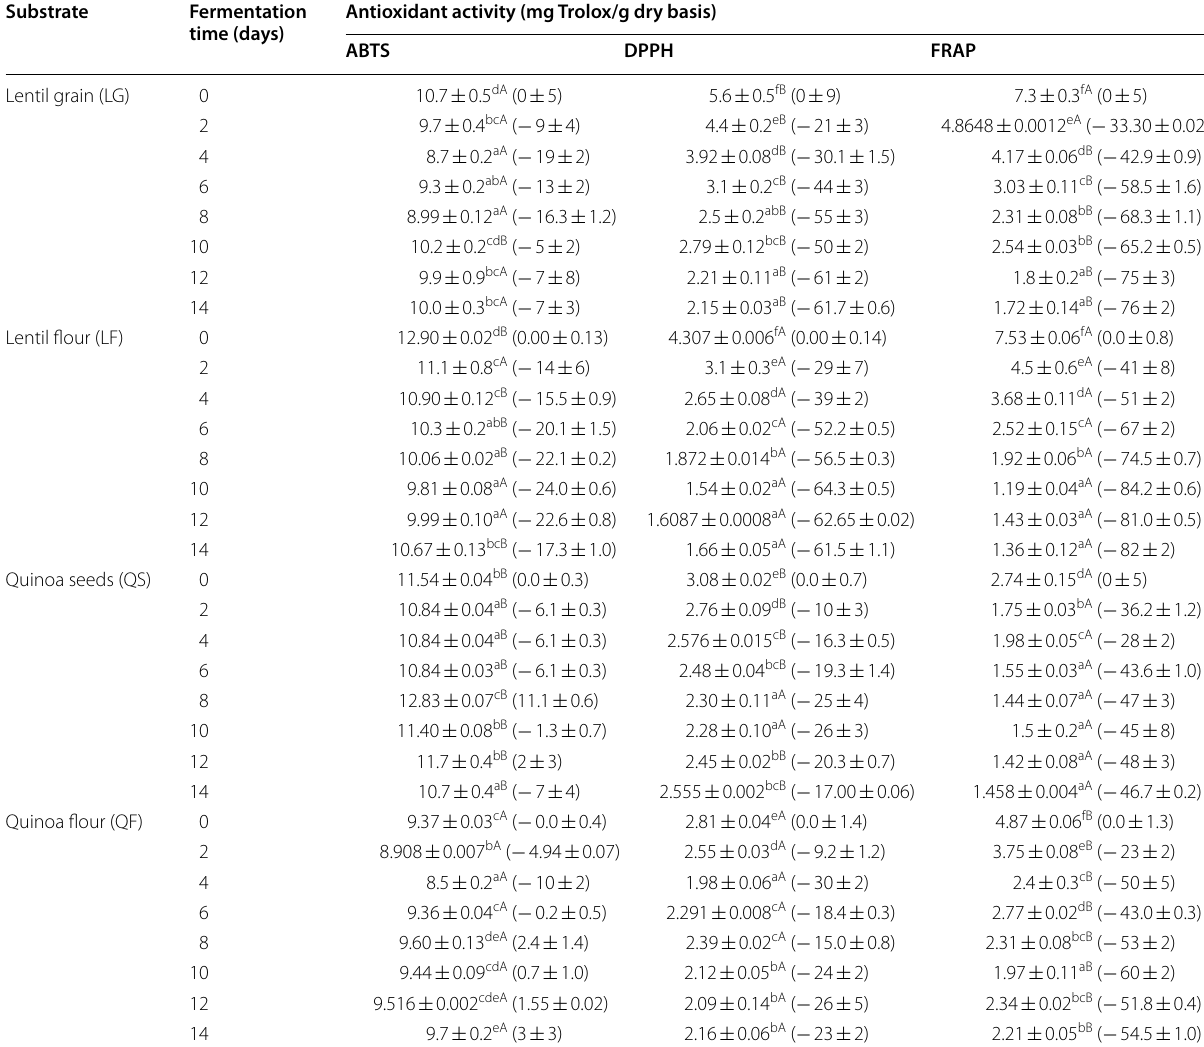
Table 3 Antioxidant activity in lentil grain, quinoa seeds and respective flours at different fermentation times